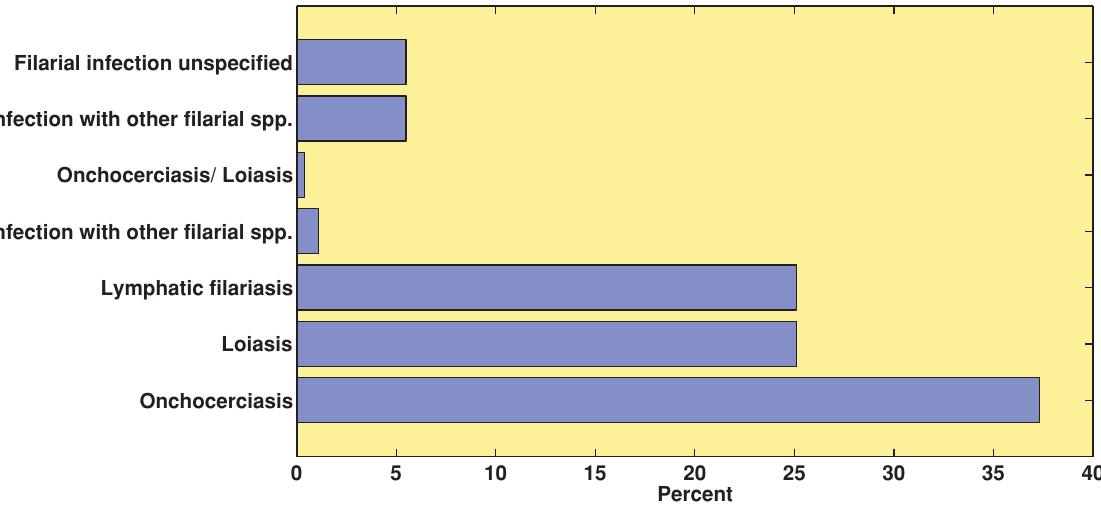
Figure 1. Distribution of filarial infections among international travelers reported in the GeoSentinel Surveillance Network.